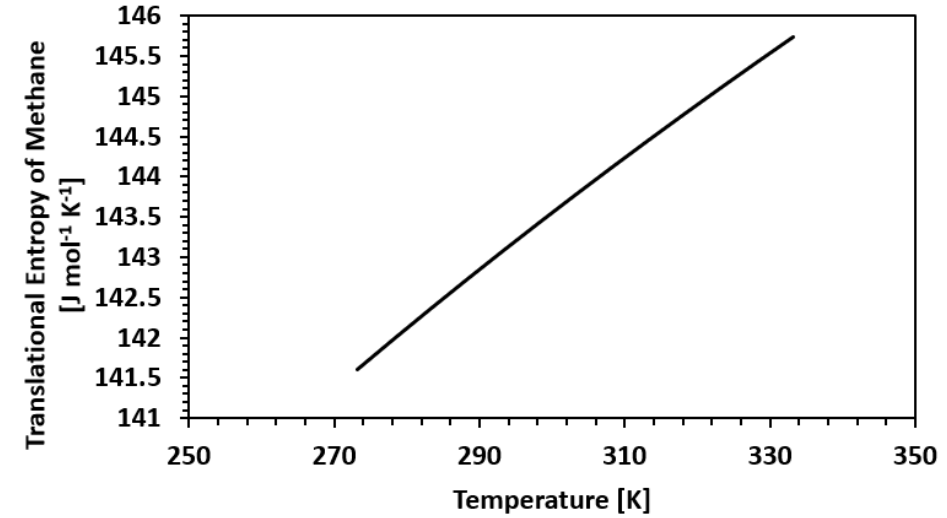
Figure 2. Methane translational entropy as a function of temperature determined using the Sackur Tetrode equation.